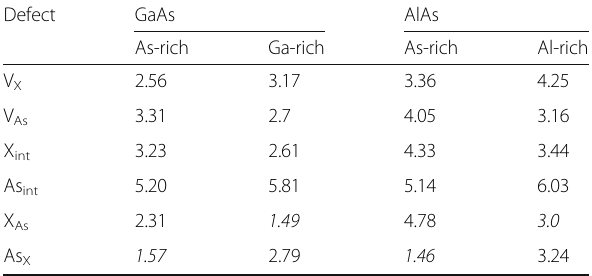
Table 2 The calculated defect formation energies (eV) in bulk XAs (X = Al or Ga) under As-rich and X-rich conditions. The minimum values are indicated in italic Defect GaAs AlAs As-rich Ga-rich